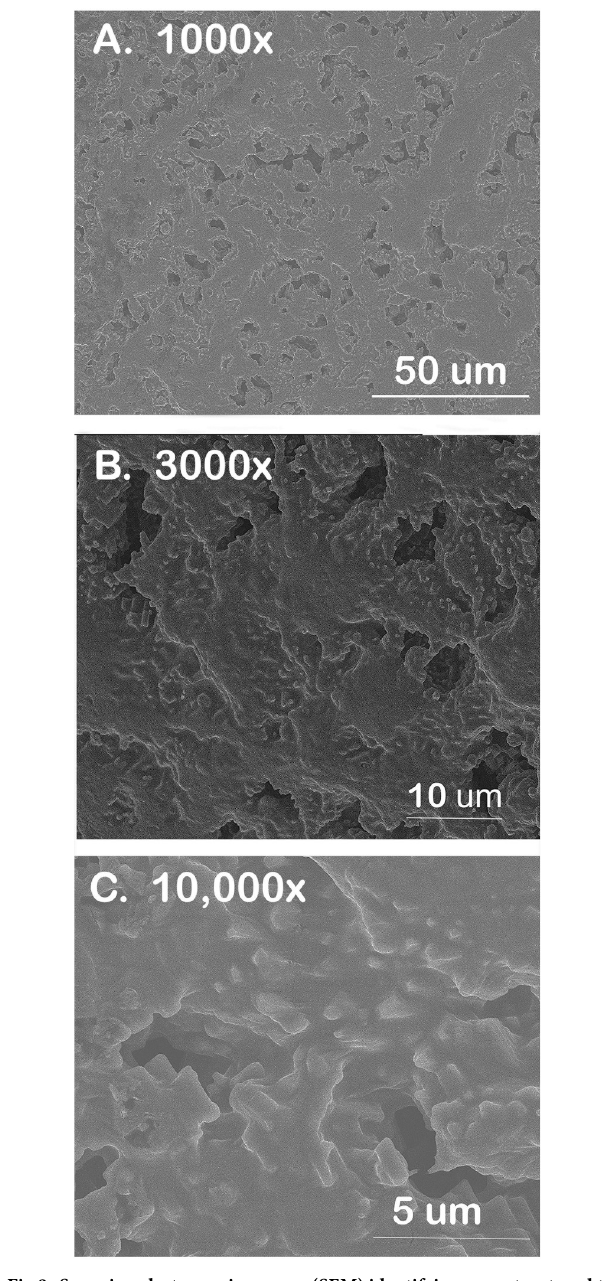
Fig 9. Scanning electron microscopy (SEM) identifying nanostructured topography of pNPs coated onto an over- the-wire balloon. Segments of the balloon were carefully dissected from the balloon catheter under a light microscope before transferring to an SEM stab for imaging. Shown are representative images acquired at A) 1000x, B) 3000x and C) 10,000x magnification.